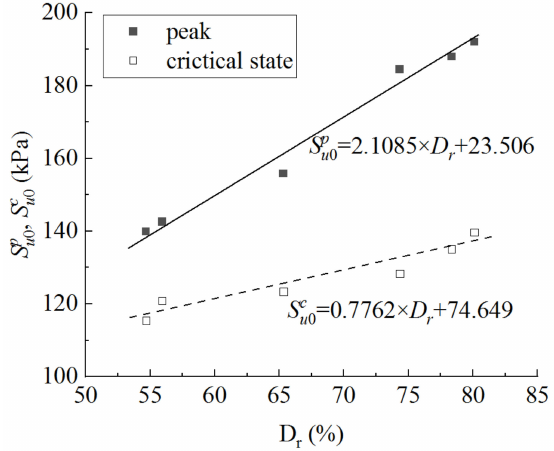
derived from u 0 and S c with u 0 u 0